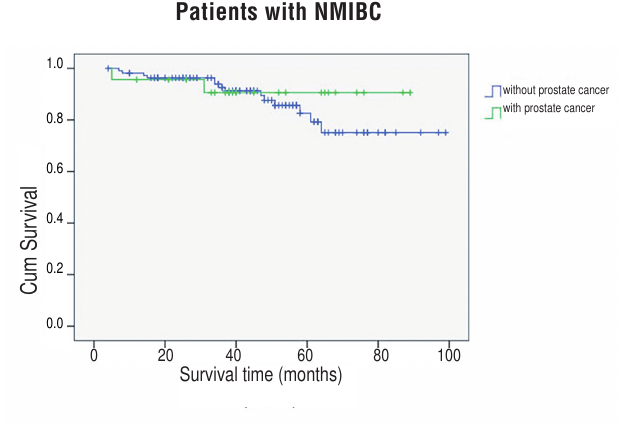
Figure 3 - Estimated Kaplan-Meier overall survival curves for patients with non-muscle invasive bladder cancer stratified by presence of prostate cancer ( P